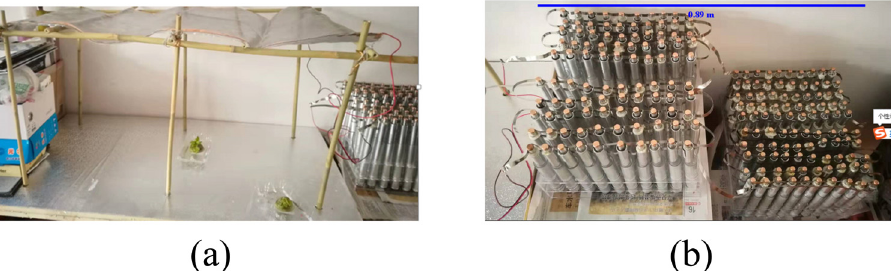
Figure 8: Aluminum - air batteries with K 2 SO 4 electrolyte ( a ) compose in 200 single aluminum air batteries with 12 V and 20 mA for PVA - CF transparent conductive fi lm; ( b ) to parallel connect 10 single battery and series connect 20 battery groups and all in one.